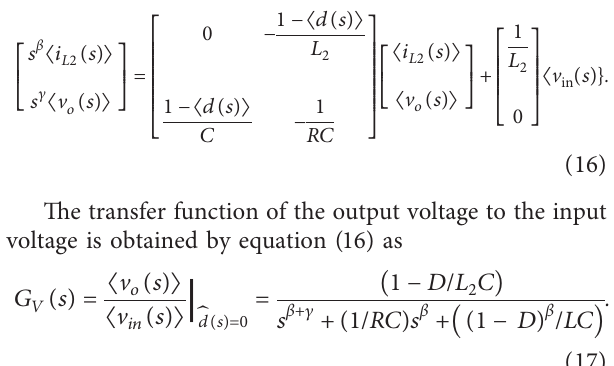
Figure 4: Equivalent dual-Boost converter of variable structure HESS.